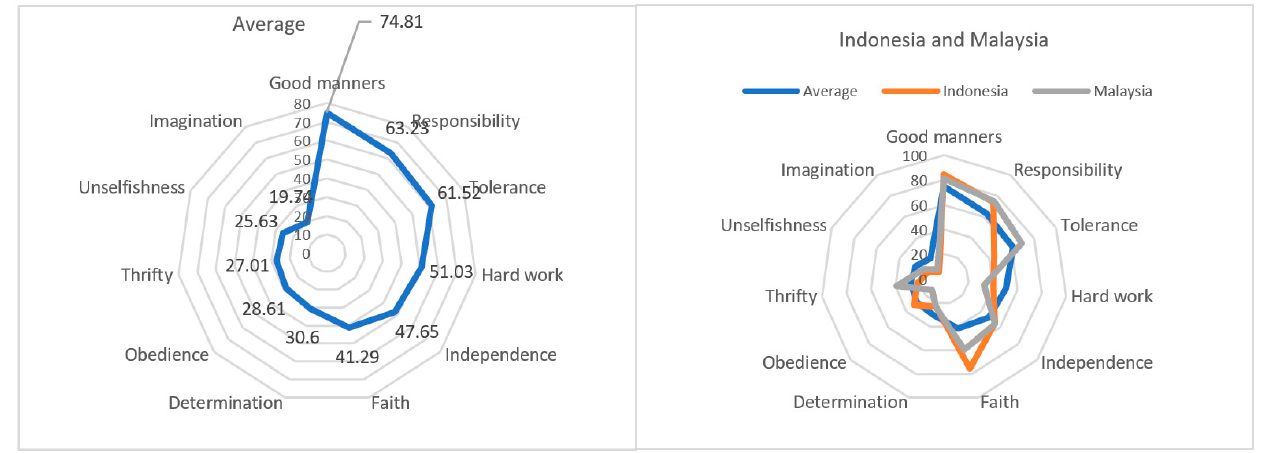
Figure 5. Qualities to develop for the future generation in Indonesia and Malaysia.